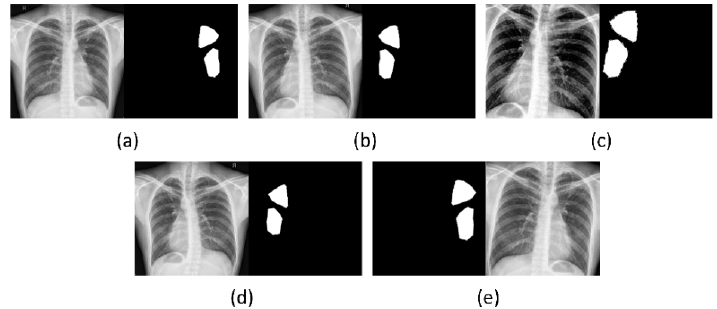
Figure 1. Augmented samples for a CXR instance from the training set. ( a ) Original CXR and its associated TB-consistent region mask; ( b ) horizontal flipping; ( c ) horizontal flipping, contrast change, and zooming; ( d ) elastic distortion, and ( e ) zooming and clockwise rotation.